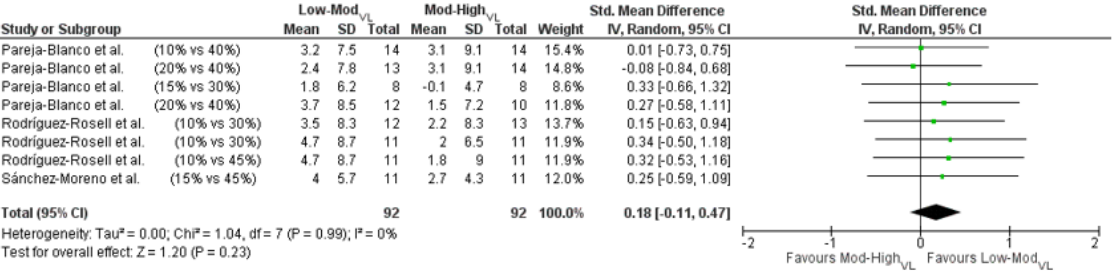
Figure 8. Bubble plots showing the relationship between individual VL thresholds and their respec- tive effect size (ES) in each outcome. The size (area) of the bubbles represents the number of exper- imental groups ( k ) included in each VL threshold. A minimum of two groups ( k ≥ 2) training the same individual VL threshold was required to include it in the relationship analysis.